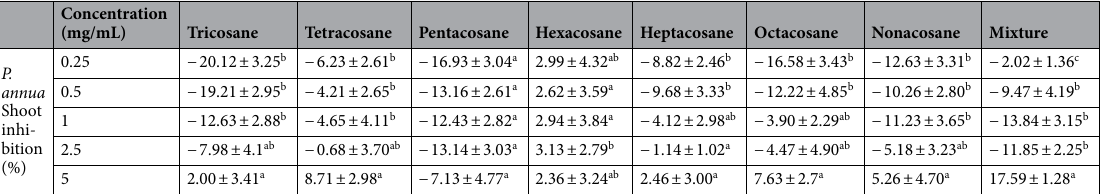
Table 5. Phytotoxic activity of alkanes on shoot growth of P. annua . a ± Standard error ( n = 30). b Different letters represent a significant difference at p < 0.05 level according to Fisher’s LSD test.